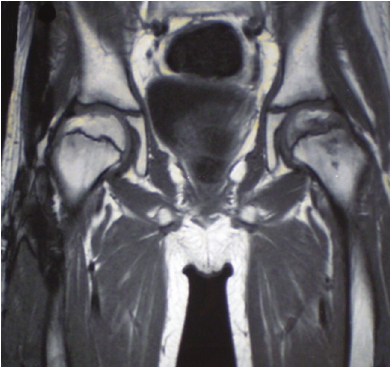
Figure 2: Bilateral joint e ff usion and bone marrow oedema are disappeared. The right femoral head shows a regular articular surface but with aspects of midollary sclerosis. Partial aspect of fragmentation on the left femoral capital